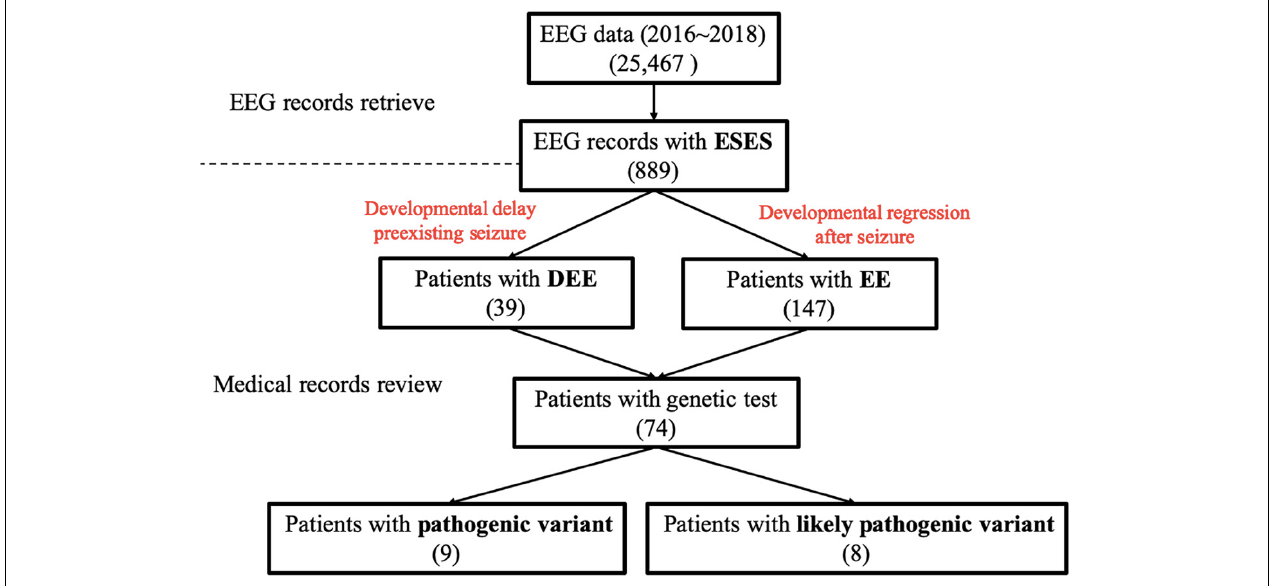
FIGURE 1 | Data screening flow chart. EEG, electroencephalography; DEE, developmental and epileptic encephalopathy; EE, epileptic